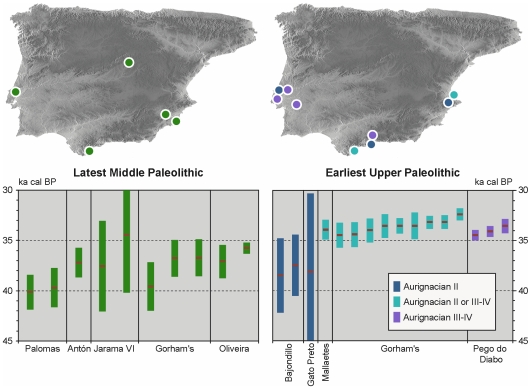
Geography and chronology of the Middle-to-Upper Paleolithic transition in southwest Iberia.Top, site locations, from West to East (Latest Middle Paleolithic: Gruta da Oliveira; Gorham's Cave; Jarama VI; Cueva Antón; Sima de las Palomas. Earliest Upper Paleolithic: Pego do Diabo and Gruta de Salemas; Gato Preto; Vale de Porcos; Gruta do Escoural; Gorham's Cave; Cueva Bajondillo; Cueva de Zafarraya; Cueva Beneito; Cueva de Mallaetes). Bottom, plot of the mid-points and 95% confidence intervals of the AMS radiocarbon results for layer 2 of Pego do Diabo compared with the dataset in Table S7 (only sites and dates that passed taphonomic critique are retained [19], [50]; the age for Gato Preto derives from the TL dating of burnt flint; the ages for the other sites derive from calibrated radiocarbon results on charcoal and bone).